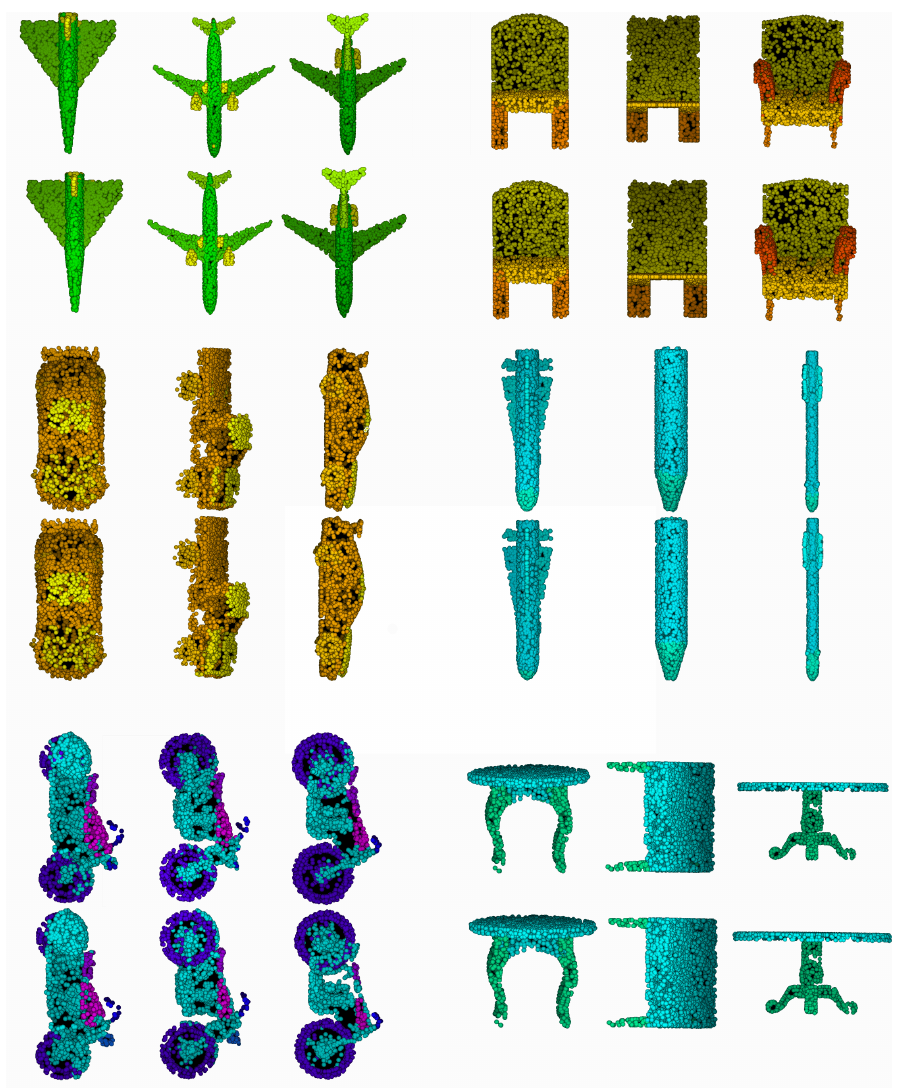
Figure 10. More visualizations of segmentation on ShapeNet dataset. Different segments are represented by different colors. The upper object of a pair is the prediction of AttPNet and the lower one is the ground